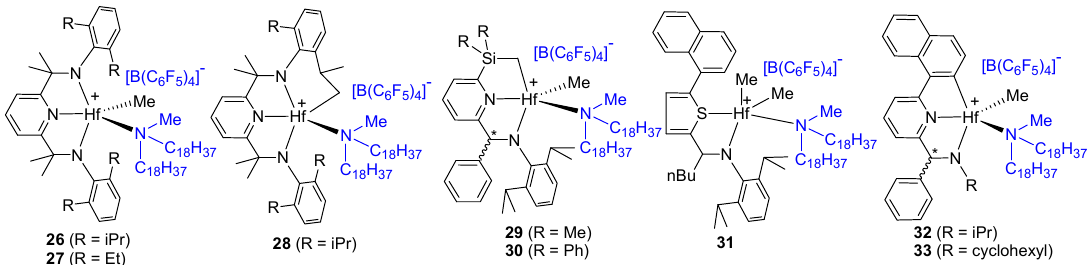
Figure 4. 1 H NMR spectra of 3 and its reaction complexes with [(C 18 H 37 ) 2 N(H)Me] + [B(C 6 F 5 ) 4 ] − ( 26 and 28 ).